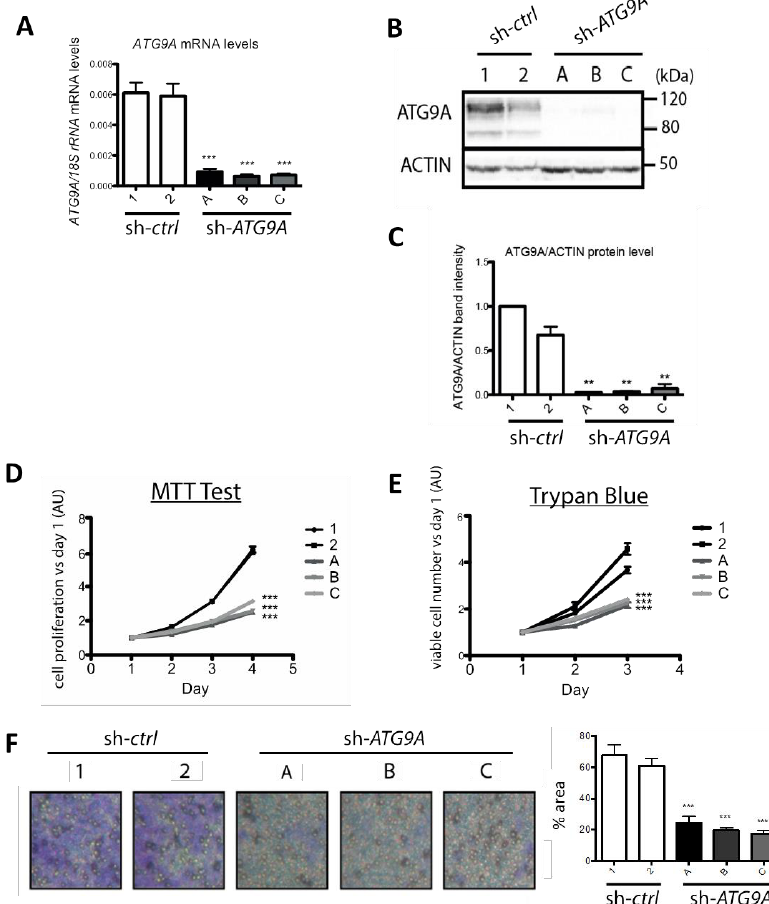
Figure 3. Inhibition of ATG9A expression using shRNA inhibits in vitro cell proliferation and invasion in the TNBC cell line MDA-MB-436. ( A ) ATG9A mRNA expression levels quantified by RT-qPCR in stable MDA-MB-436 clones expressing a sh- control (1 and 2) or a sh- ATG9A (A, B, and C; n = 3, duplicate). Values were normalized using the housekeeping gene rRNA18S . Difference in expression was quantified using a t-test: Compared to sh- control 1, p < 0.0001 for all sh- ATG9A clones (A, B, and C); compared to sh- control 2, p = 0.0002 for sh- ATG9A clone A and p < 0.0001 for sh- ATG9A clones B and C. ( B ) Levels of ATG9A and ACTIN proteins in the sh- control (clones 1 and 2) or sh- ATG9A (clones A, B, and C) clones. A representative image of three independent experiments is shown. ( C ) Quantification of ATG9A protein levels normalized to ACTIN protein levels, quantified using the ImageLab software ( n = 3). The difference in expression was determined using a t-test: compared to sh- control 2, p = 0.0023; p = 0.0024, and p = 0.0048 for sh- ATG9A clones A, B, and C, respectively. ** p ≤ 0.01. Proliferation rates of sh- ATG9A and their controls using a MTT ( D ), or a Trypan-blue exclusion assay ( E ). The MTT assay was conducted every day over a four-day period ( n = 3, 16 replicates). The difference in cell proliferation was quantified using a t-test at day 4. *** p ≤ 0.001 * p ≤ 0.05. For the trypan blue exclusion assay, viable cells were counted every day over a three-day period ( n = 3, four replicates). The difference in cell number versus day 1 was quantified using a t-test at day 3 (graphs on the right). ( F ) The invasion assay was performed using sh- ATG9A (clones A, B, and C) and control clones (1 and 2). A representative image of three independent experiments with duplicates is shown on the left. The graph on the right represents the percentage of cells that migrated through the ECM-coated Boyden chambers after 24 h, quantification was done with the ImageJ software. The difference in cell density was quantified using a t-test. *** p ≤